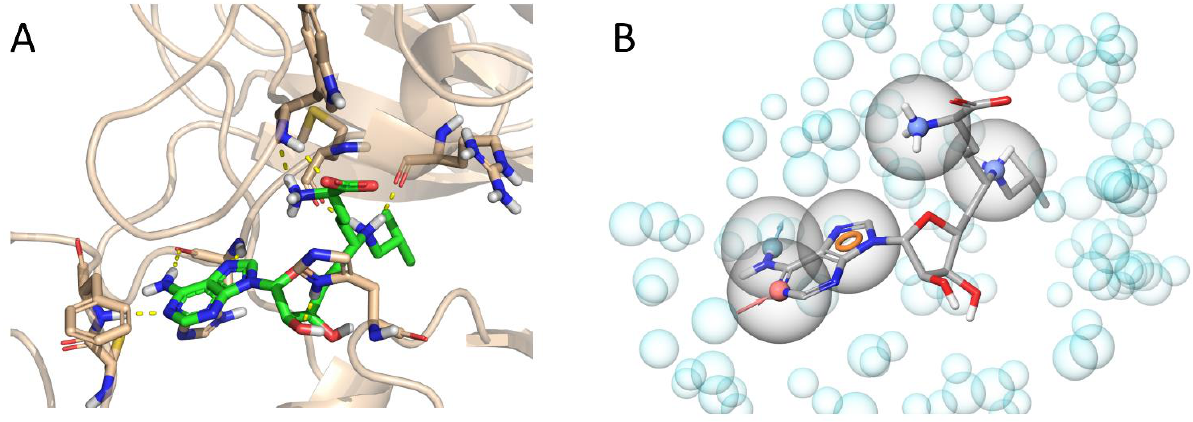
Figure 2. ( A ) Isobutyl-sinefungin (iBu-SNF, PDB:5LSY [15]) in the SAM-binding pocket of SETD2. ( B ) Consensus pharma- cophore model overlaid on the structure of iBu-SNF.